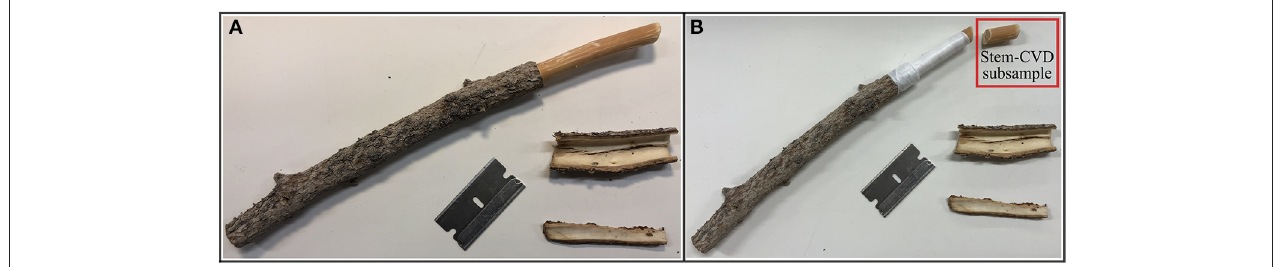
FIGURE 1 | Example of preparation of stem sample immediately after pruning (A) and following the subsampling of roughly 1cm cut section for cryogenic vacuum distillation (CVD) extraction for Stem-CVD composite subsamples and Teflon wrapping of remaining stem sample before Scholander-type pressure chamber (PC) water extraction for Stem-PC composite samples (B) . Figure includes an example stem of Blue Spruce at Campus location for visualization and this particular stem was not actually used for extractions.